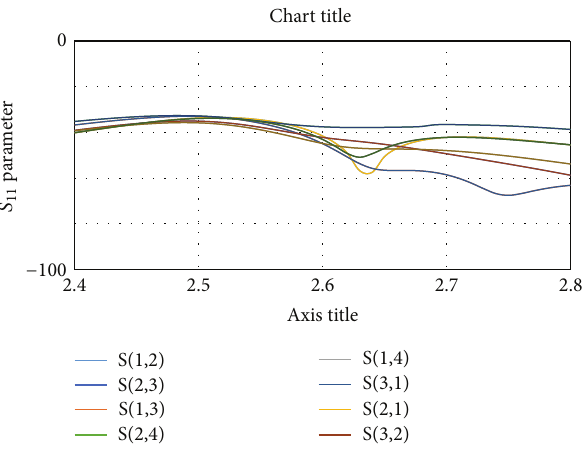
configuration allows each of the four antennas to adjust the pilot power to optimize the antenna coverage. Along with the switching techniques, the microstrip antennas shape up the radiation pattern according to the house model and users’ position. The antenna characteristics and the substrate choice indicates that it is suitable for commercial deployment in femtocell devices. It will also reduce the cotier and crosstier interference in dense femtocell